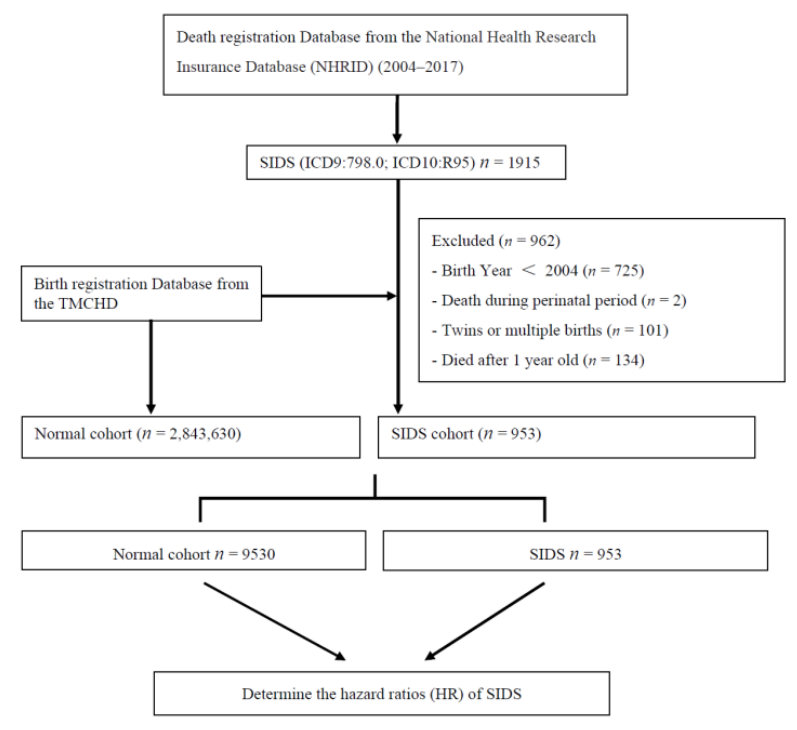
Figure 1. Study flowchart.